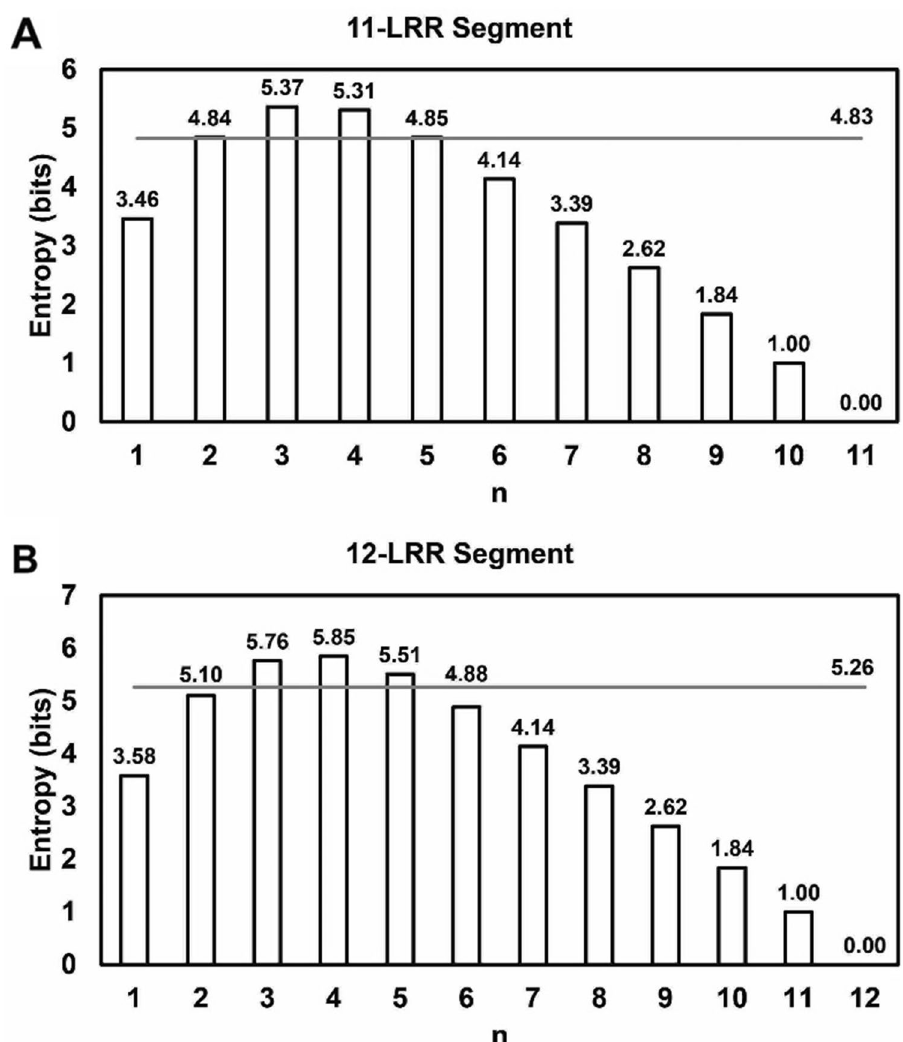
Figure 2. Information entropy for different LRR segmentation lengths. Information entropy for experimentation involving sub-segments of length n (number of repeats) from a segment of length ( A ) 11 or ( B ) 12. The grey bar indicates a level above which at least 90% of maximal information is